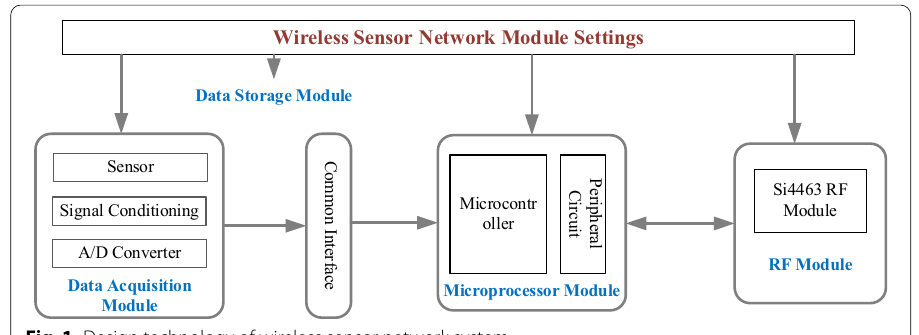
Fig. 1 Design technology of wireless sensor network